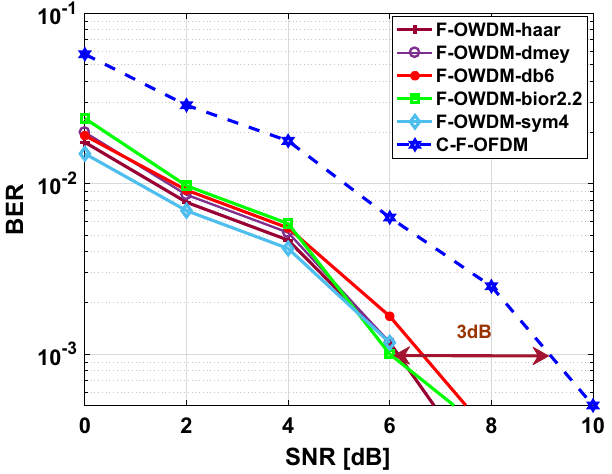
Figure 10. Comparison of BER of the F-OWDM and C-F-OFDM signals based on the 4-QAM modulation technique.